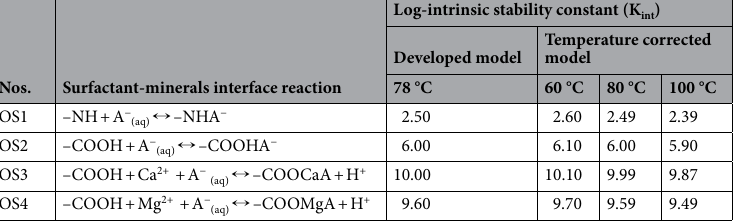
Table 10. Surface complexation reactions with intrinsic stability constants at the oil-surfactant interface.